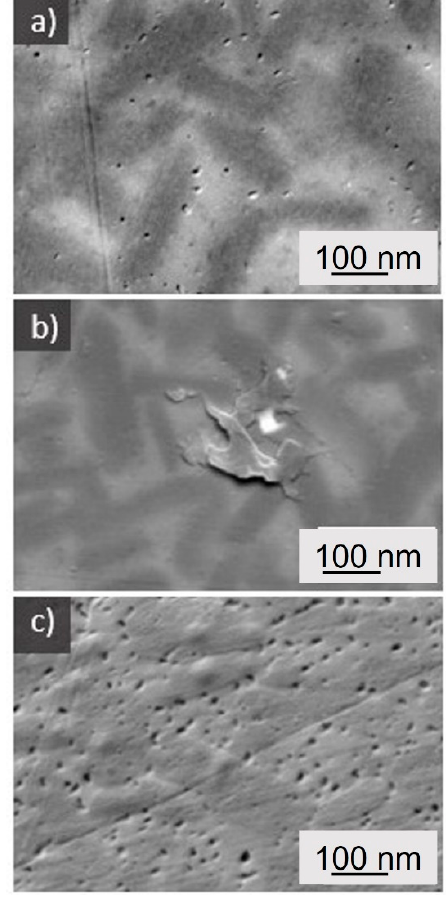
Figure 5. Representative SEM images for material A: ( a ) after the dynamic test for 96 h in 4% acetic acid ( b ) after the static test for 16 h at 80 °C (ISO 6872) ( c ) after the dynamic test in an alkaline solution (pH 10). Table 5. Positions and assignment of bands in ATR